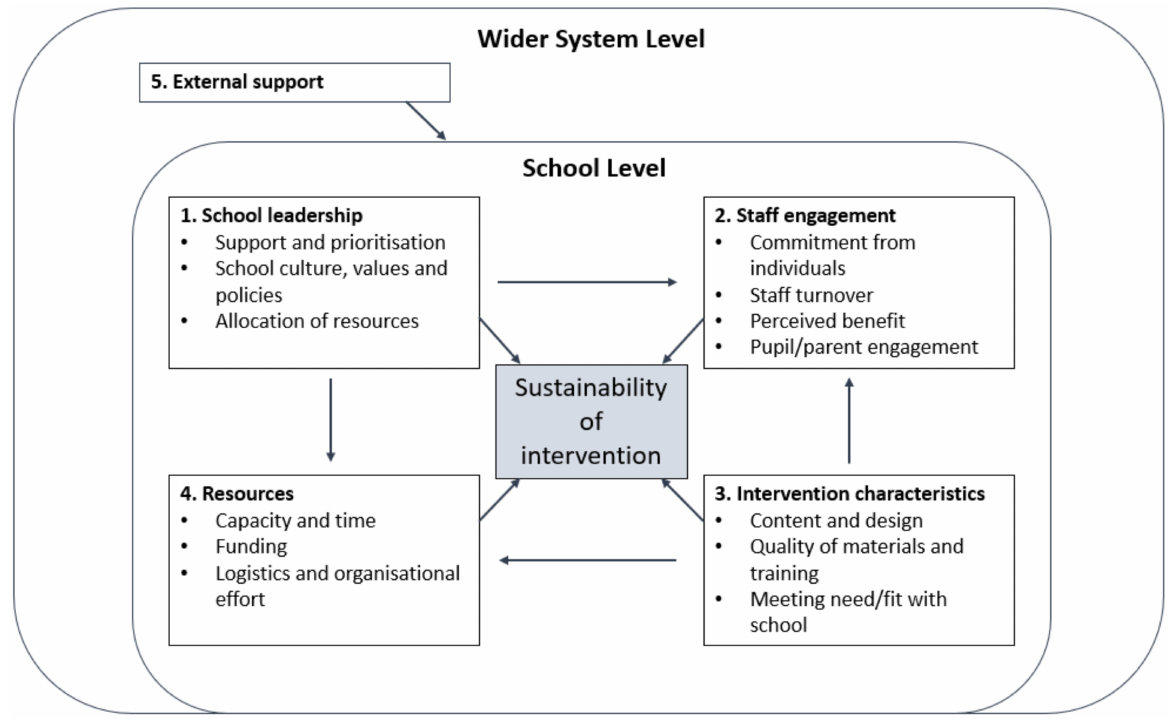
Figure 2. Thematic map of factors affecting